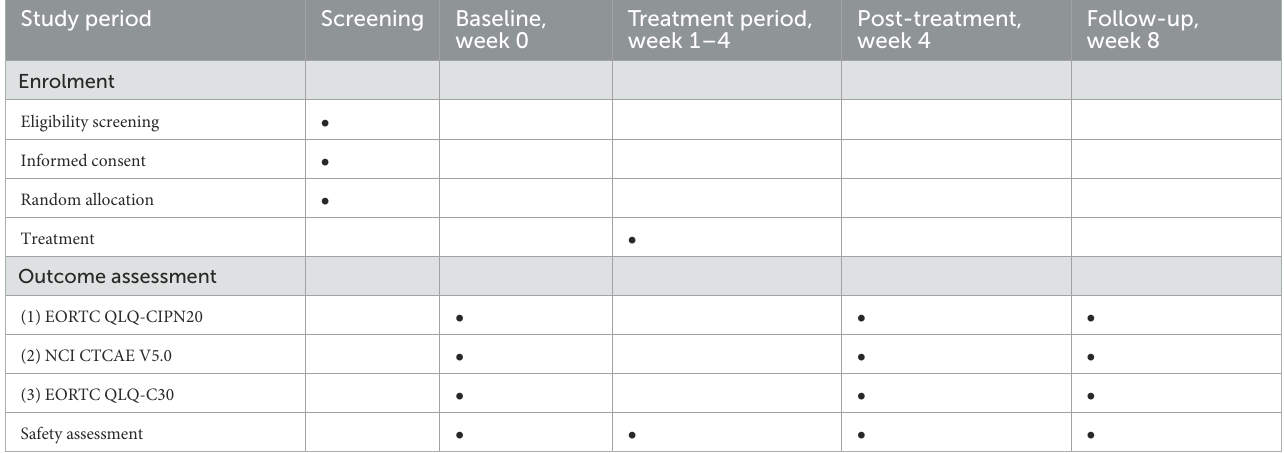
TABLE 1 Schedule of enrolment, treatments, and assessments.